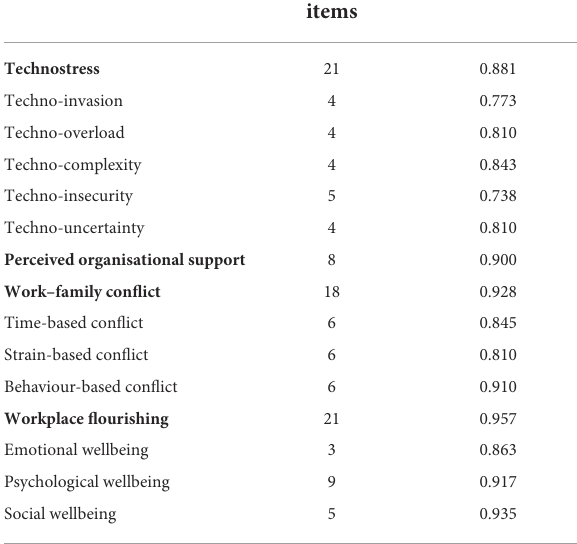
TABLE 1 Reliability of the